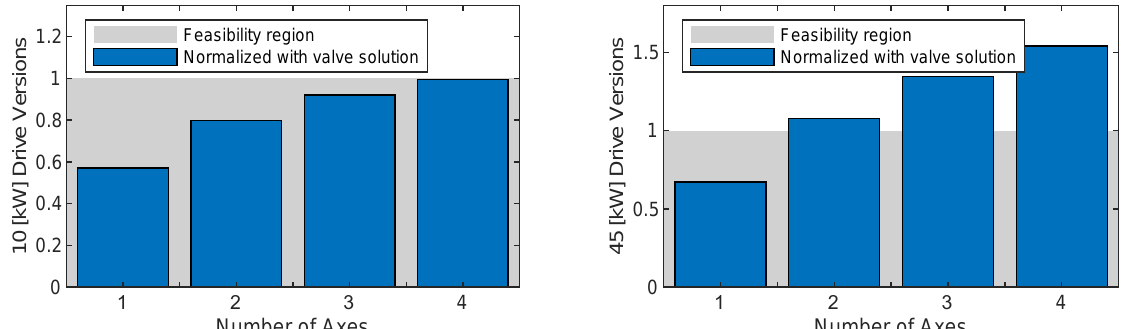
Figure 14. Cost of proposed drive architectures DPDS-R, DPCS-R, normalized with valve solutions. Gray areas imply feasible regions, i.e., regions where drive architectures DPDS-R, DPCS-R are more cost effective than a conventional valve